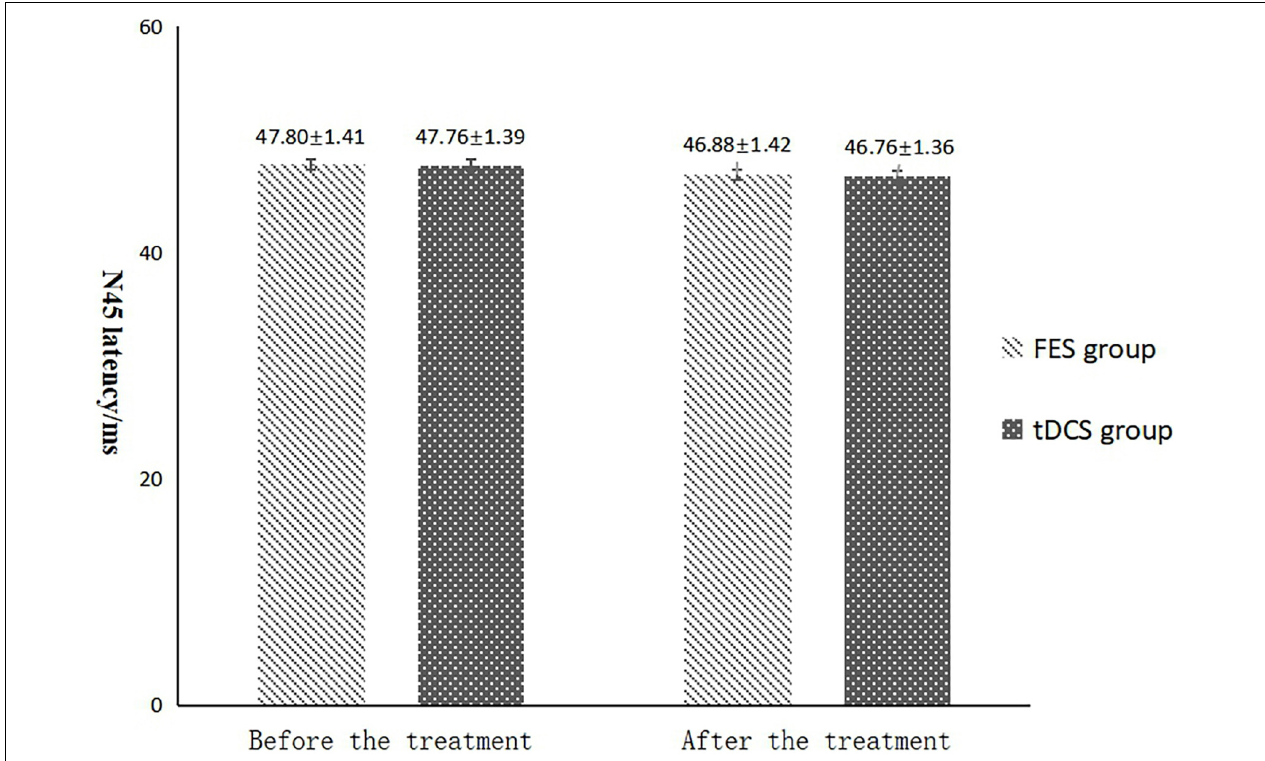
FIGURE 6 | N45 latency comparing improvement before and after FES and tDCS treatments in post-convalescent stroke patients. ∗ Indicates that the mean value of the tDCS and FES groups is significantly different at the same time point, p < 0.05. # Indicates that the mean score after treatment is significantly different from that before treatment, p <